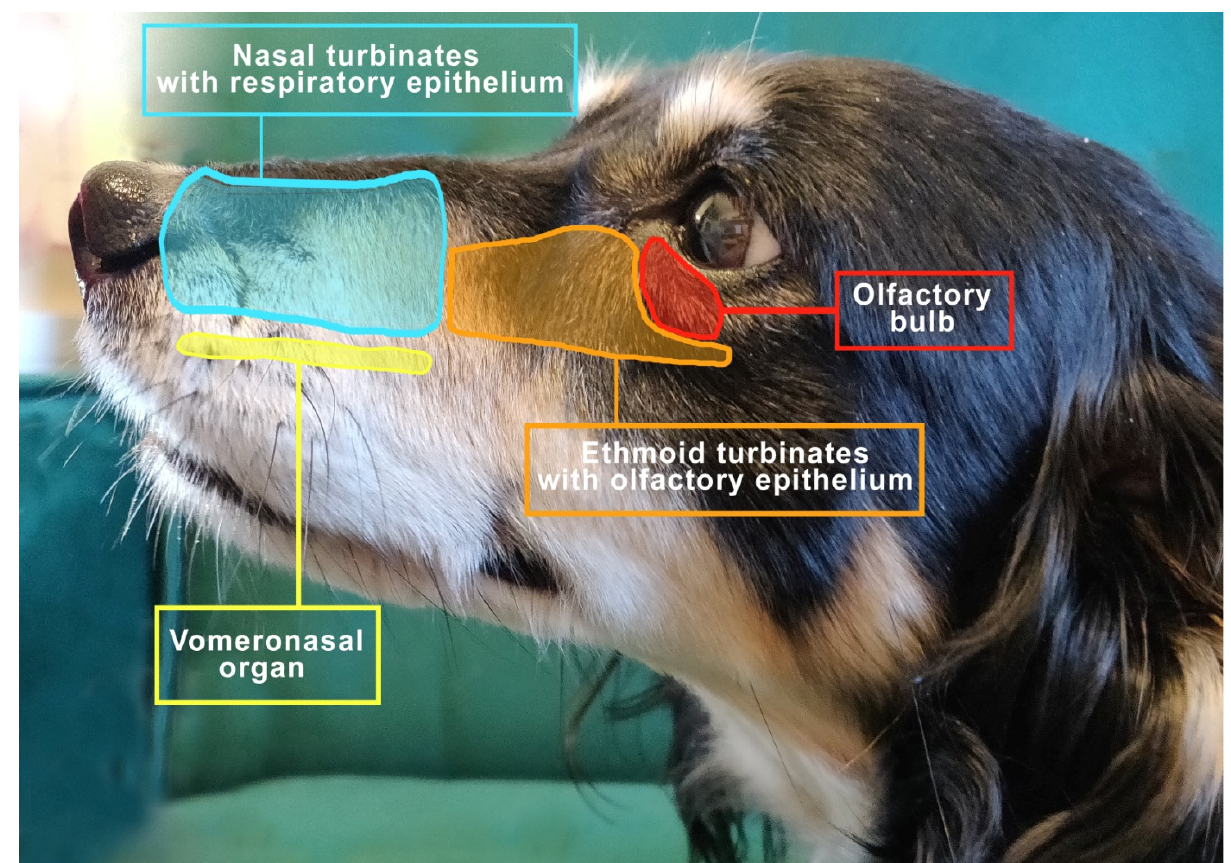
Figure 1. The view to the left of the mesocephalic dog’s head shows the distribution of important structures related to respiration and smell. structures related to respiration and